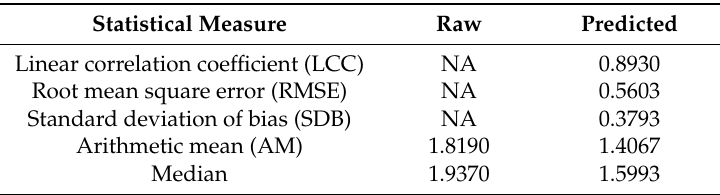
Table 3. Comparison of predicted and raw yearly log-transformed numbers of human brucellosis cases in the assessment phase (2009–2010) in Inner Mongolia, China.